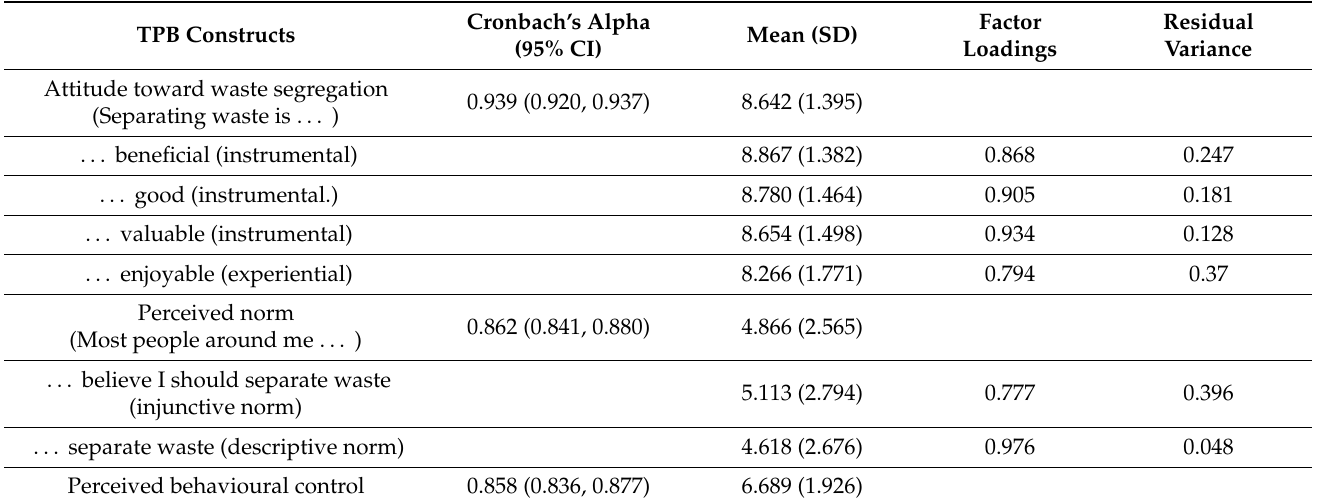
Table 2. Internal consistency estimates, means, and factor loadings of the TPB